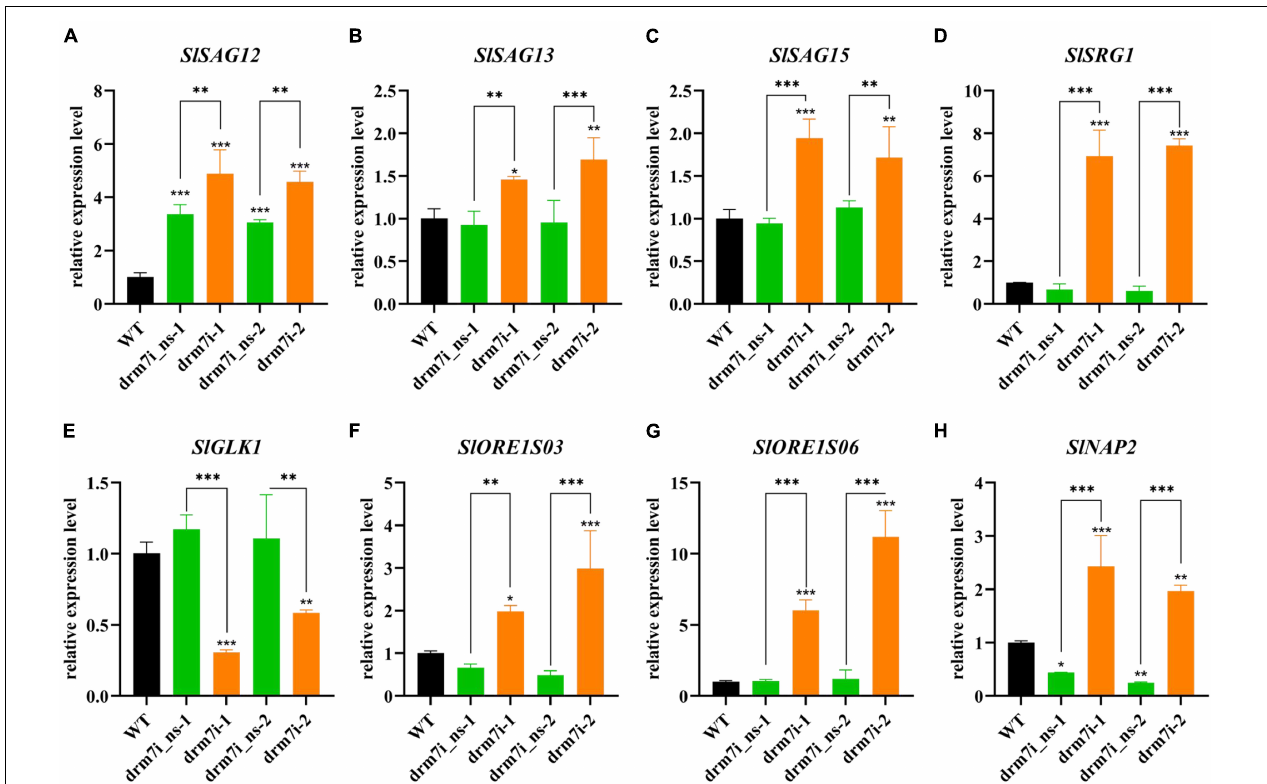
FIGURE 3 | Expression analysis of senescence-associated genes in WT and SlDRM7 -RNAi leaf tissues. (A–H) RT-qPCR analysis of the relative expression levels of SlSAG12 (A) , SlSAG13 (B) , SlSAG15 (C) , SlSRG1 (D) , SlGLK1 (E) , SlORE1S03 (F) , SlORE1S06 (G) , SlNAP2 (H) in mature leaves of the WT, two drm7i_ns lines, and two drm7i lines, respectively. Data are means ± SD of three biological duplicates. Asterisks (above error bar represent the difference with WT; above the short line represent the difference with drm7i_ns lines) indicate the significant differences ( ∗ P ≤ 0.05, ∗∗ P ≤ 0.01, ∗∗∗ P ≤ 0.001, one-way ANOVA, Tukey’s